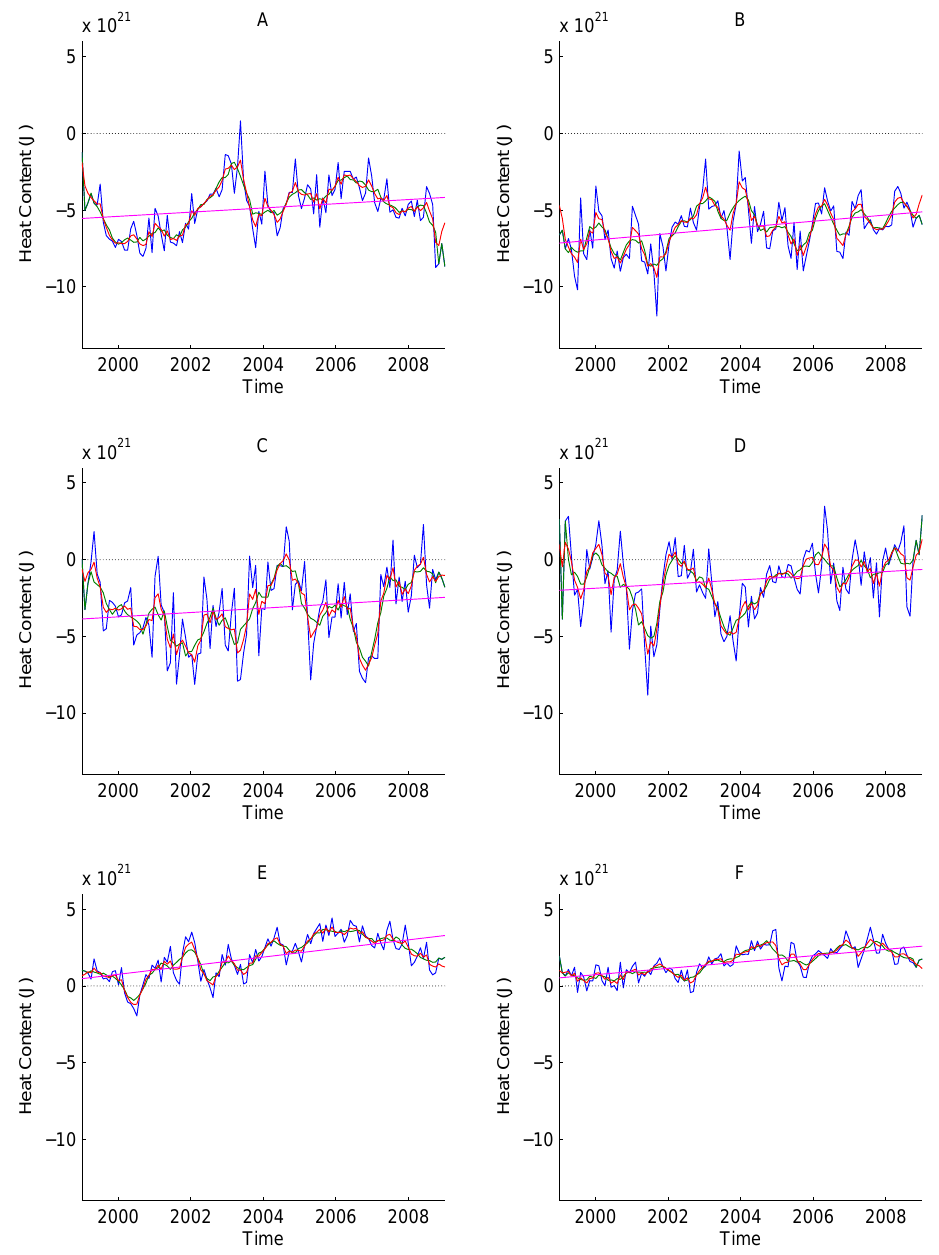
Fig. 9. Zonally integrated anomaly of heat content of the upper 2000m for the 10 ◦ belts: (a) between 10 ◦ N and 20 ◦ N; (b) between 20 ◦ N and 30 ◦ N; (c) between 30 ◦ N and 40 ◦ N; (d) between 40 ◦ N and 50 ◦ N; (e) between 50 ◦ N and 60 ◦ N; (f) between 60 ◦ N and 70 ◦